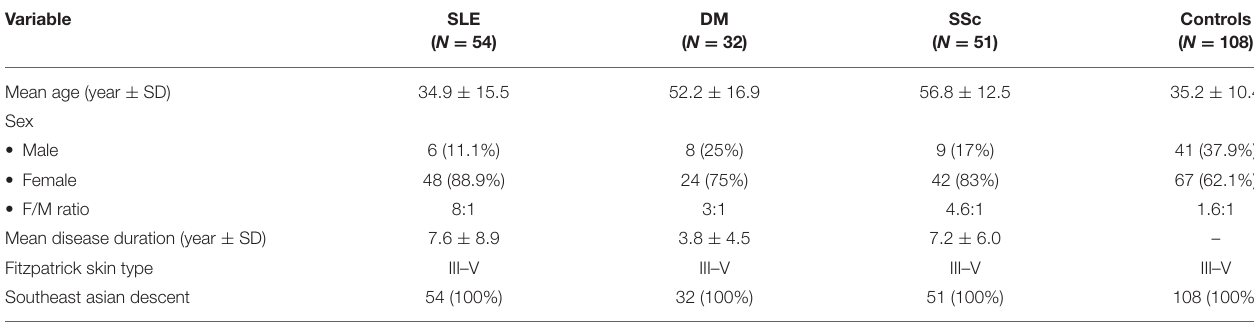
TABLE 1 | Comparison of demographic data of patients with connective tissue diseases and healthy controls.